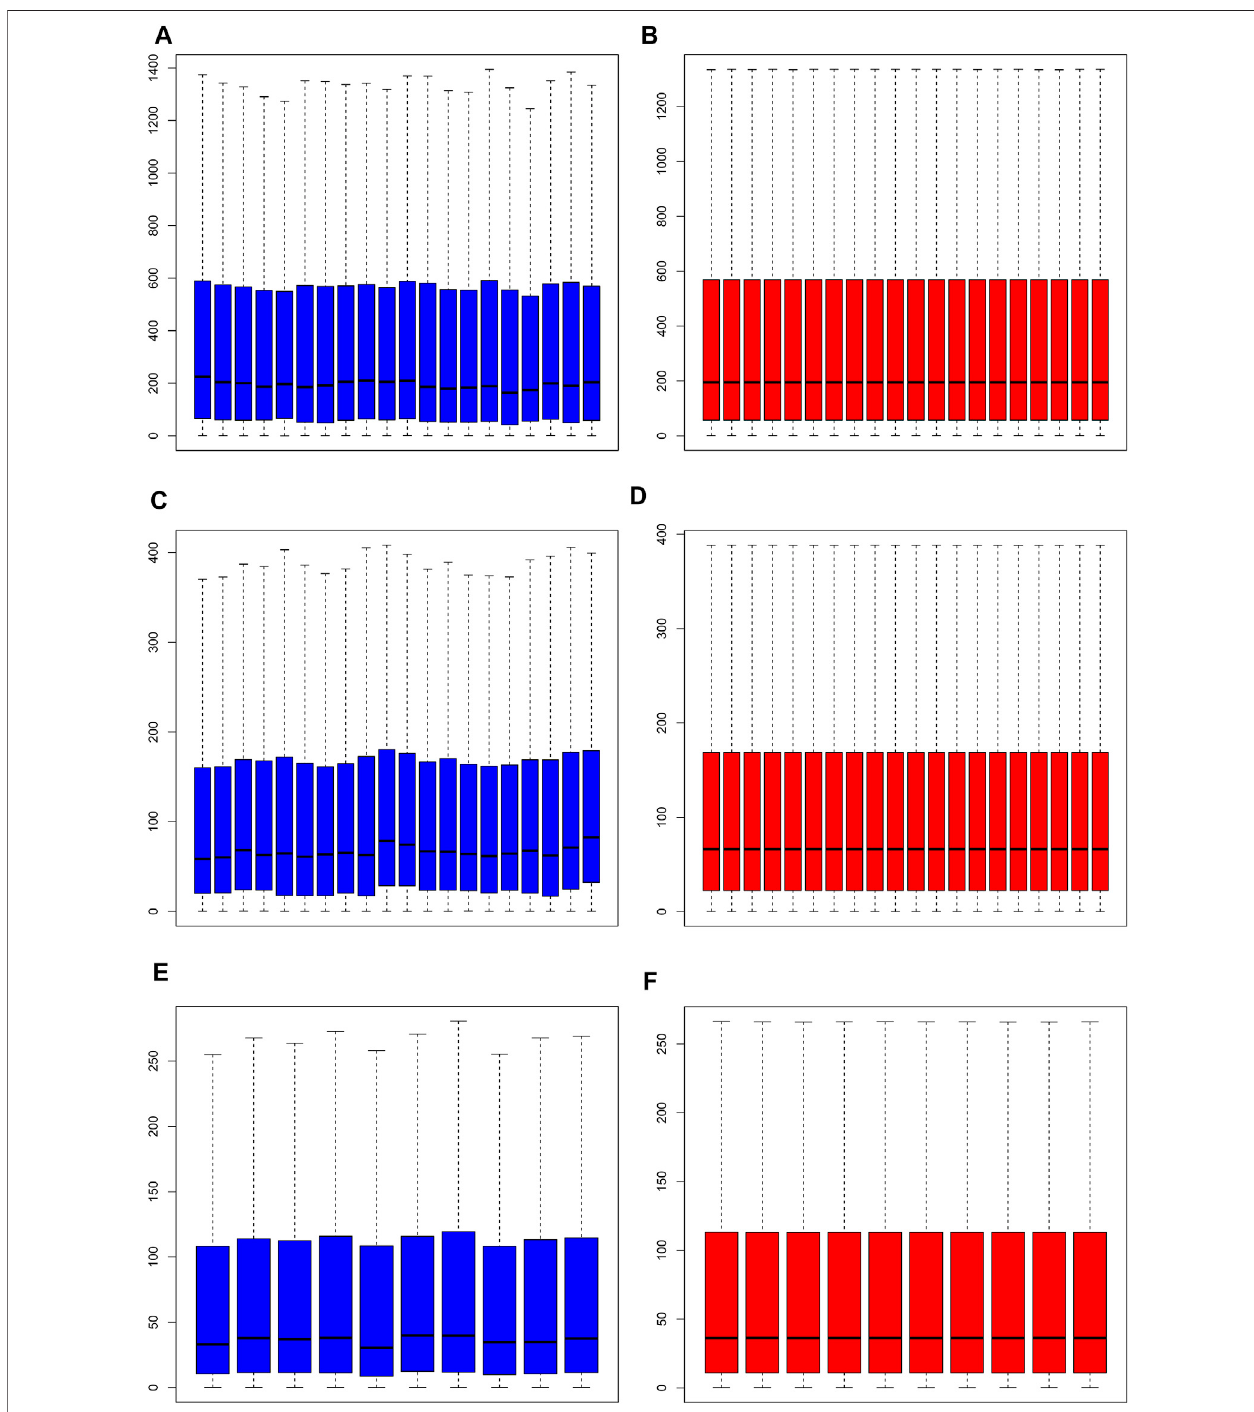
FIGURE1 | Normalization of samples. (A, C, E) Prior to normalization oftotal DEGs for GSE55457, GSE55235, and GSE1919; (B, D, F) following normalization of total DEGs for GSE55457, GSE55235, and GSE1919.